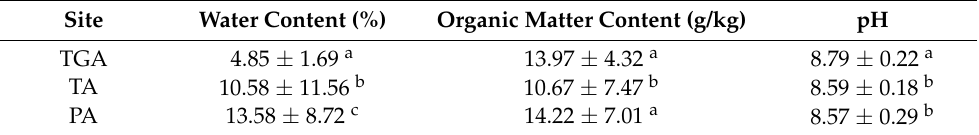
Table 5. Comparison of physical and chemical characteristics of soil at three sites subject to different levels of disturbance in the KGTA and YWNR, Beijing Municipality, China. Data are means ± standard deviations. Per column, different superscripts indicate statistically significant differences between means ( p < 0.05). Site Water Content